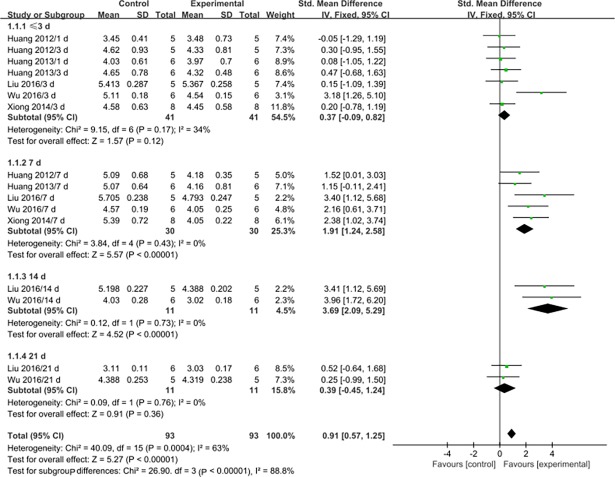
Forest plots showing the effects of MSCs on MDA levels.Control: PQ group; Experimental: MSC treatment group; CI: confidence interval; IV: independent variable; SD: standard deviation.